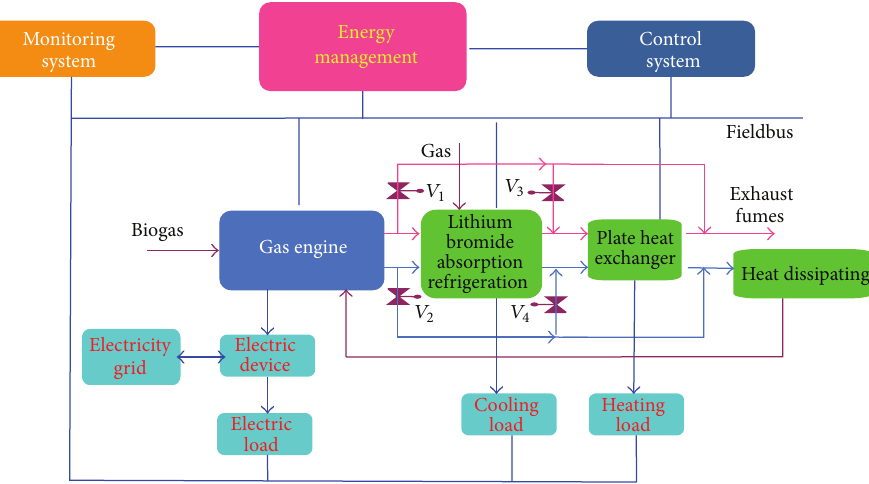
Figure 2: The block diagram of distributed generation